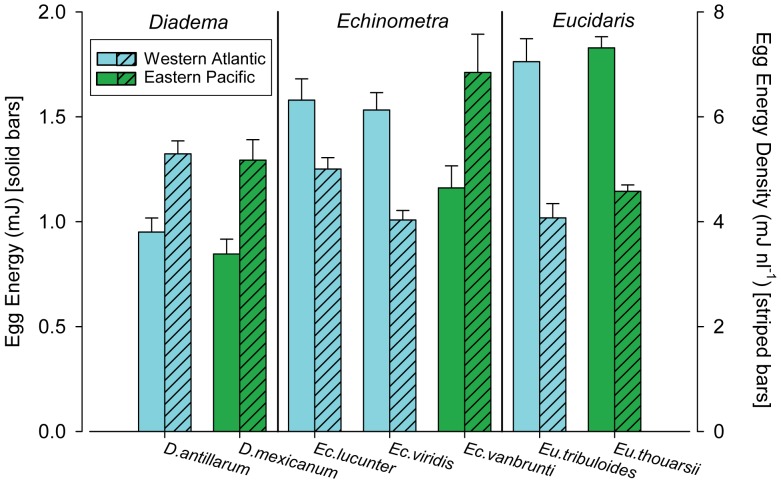
Average energy and energy density of eggs.Left vertical axis and non-patterned bars: Average (±1 SE) total energy content (mJ) per egg per species. Enthalpic energy equivalents of 39.5 µJ/ng (lipid), 24 µJ/ng (protein), and 17.5 µJ/ng (carbohydrate) were used to calculate energy content. Right vertical axis and patterned bars: Average (±1 SE) energy density (mJ nl−1) per egg per species. Western Atlantic species (blue) and Eastern Pacific species (green) are indicated.